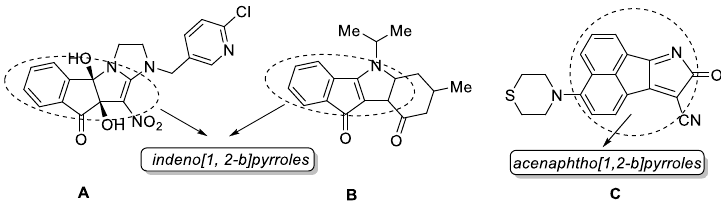
Figure 1. Biologically important indenopyrroles and acenaphthopyrroles.